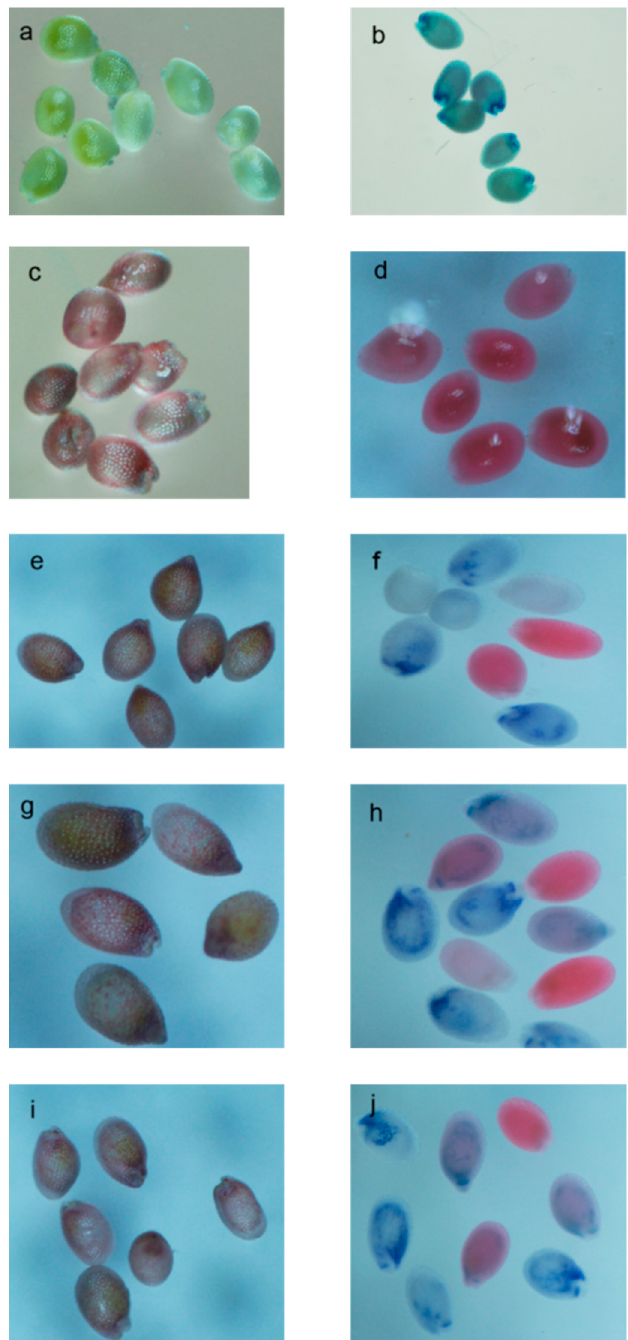
Figure 8. Genetic complementation of MiANR1-1, 1-2 and 1-3 expression in the ban mutant. Phenotypes of immature wild-type seeds ( a ), ban ( c ) and MiANR1-1, 1-2 and 1-3 transgenic ban ( e , g , i ) plants; staining with 0.1% DMACA to reveal the phenotypes of immature seeds from wild ( b ), ban ( d ), and MiANR1-1, 1-2 and 1-3 transgenic ban ( f , h , j ) plants, respectively.